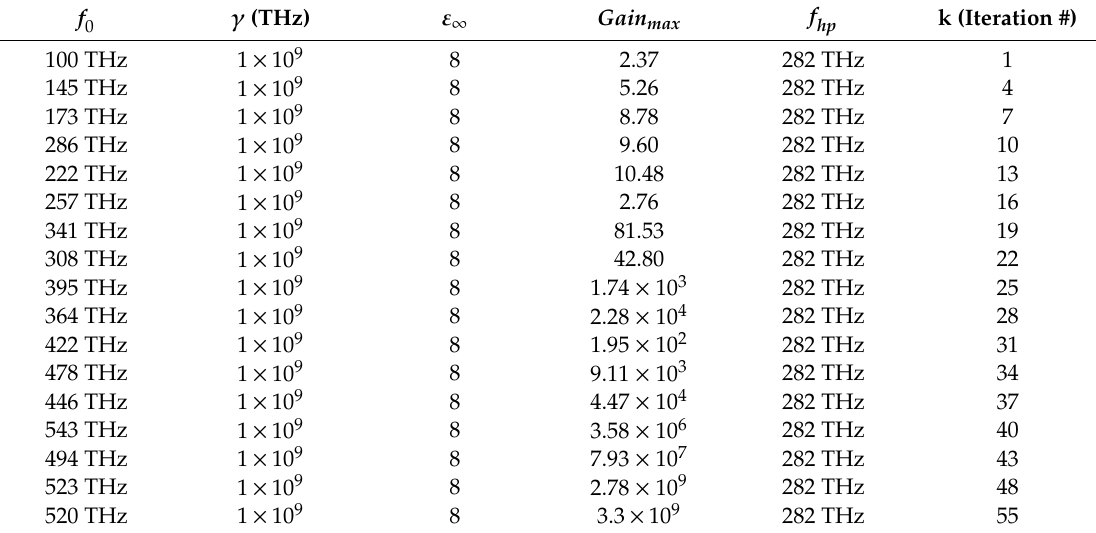
Table 1. Gain maximization by using Newton’s